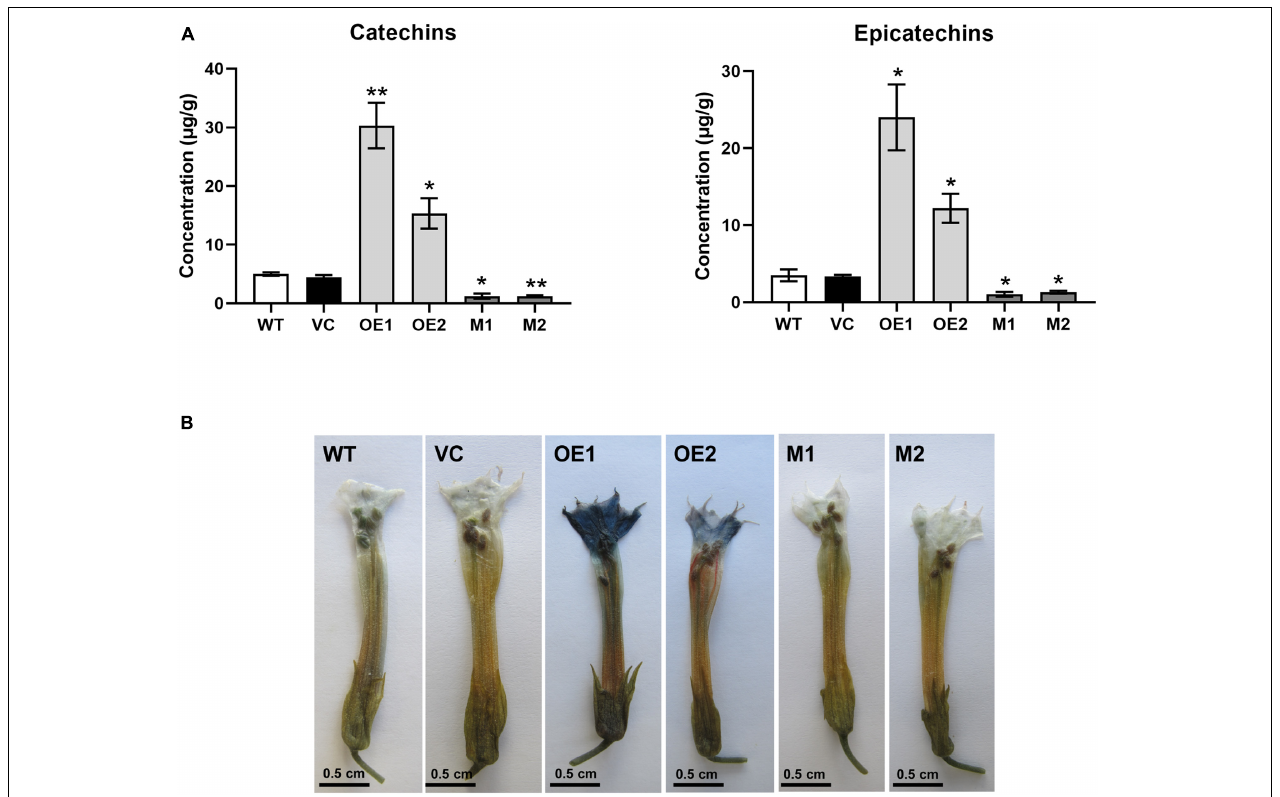
FIGURE 4 | NtMYB330 regulates PA biosynthesis in tobacco flowers. (A) Concentrations of catechins and epicatechins in the flower petals of WT, VC, NtMYB330-OE and ntmyb330 mutant plants. Data are the mean of three replicates with error bars indicating ± SD. Asterisks indicate statistically significant differences from WT according to paired t -test (* P < 0.05; ** P < 0.01). (B) DMACA staining of PAs accumulated in the flower petals of WT, VC, NtMYB330-OE and ntmyb330 mutant plants. Scale bar = 0.5